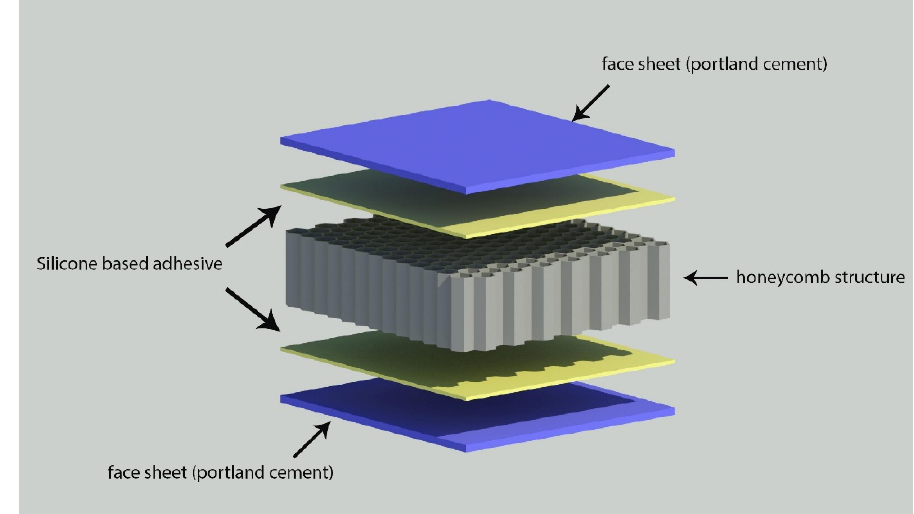
Figure 1. The schematic view of the honeycomb sandwich structure.